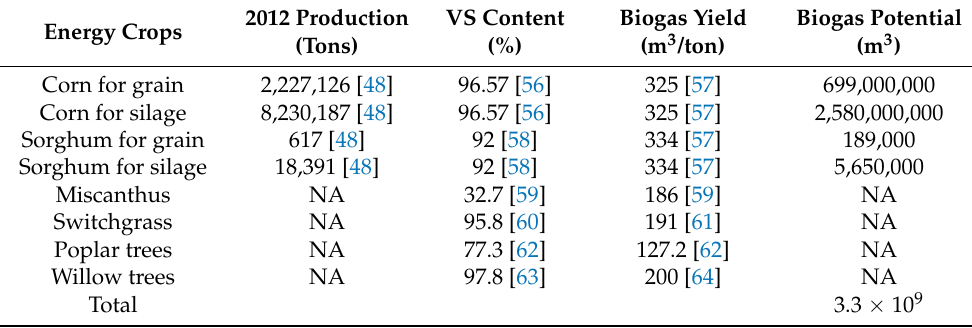
Table 1. Biogas production potential from energy crops in New York State.